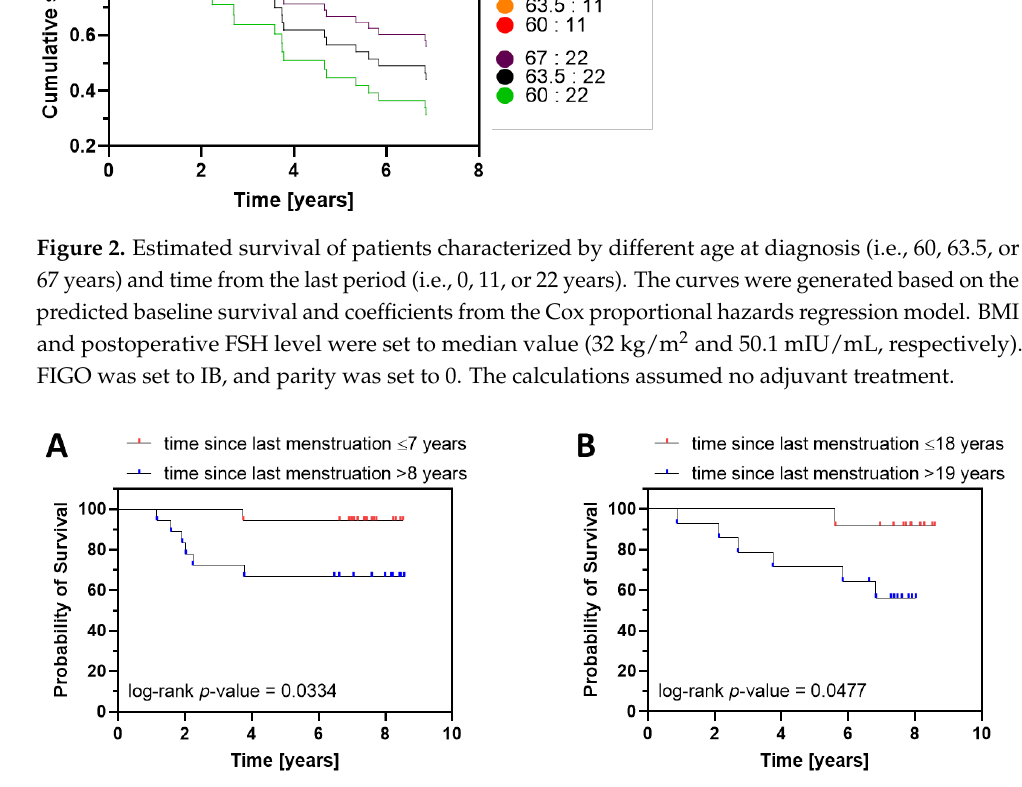
Figure 2. Estimated survival of patients characterized by different age at diagnosis (i.e., 60, 63.5, or 67 years) and time from the last period (i.e., 0, 11, or 22 years). The curves were generated based on the predicted baseline survival and coefficients from the Cox proportional hazards regression model. BMI and postoperative FSH level were set to median value (32 kg/m 2 and 50.1 mIU/mL, respectively). FIGO